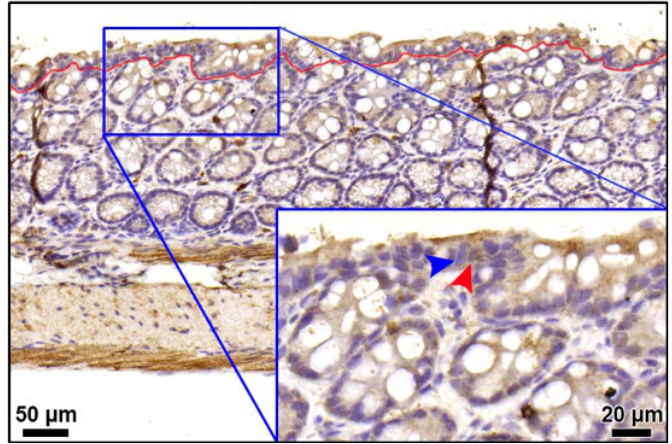
Figure 2. Representative image of TNF- α immunoreactivity for enterocyte nuclei. Immunohistochemical analysis stated the presence and location of TNF- α protein in colon specimen (scale bar, 50 μm). The superficial epithelium was the layer above the red curve. Inset showed the corresponding area at higher magnification (scale bar, 20 μm). Blue arrowhead, the TNF- α -negative enterocyte nucleus; red arrowhead, the TNF- α -positive immunocyte nucleus.